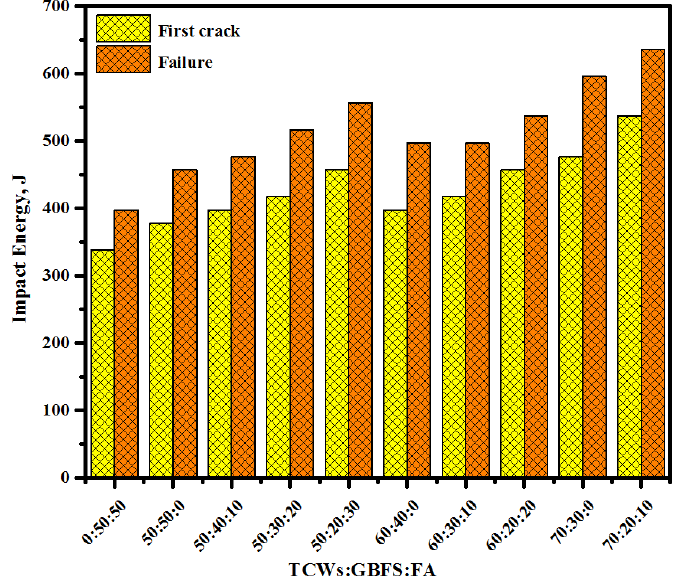
Figure 13. Impact energy of high volume TCWs based geopolymers.